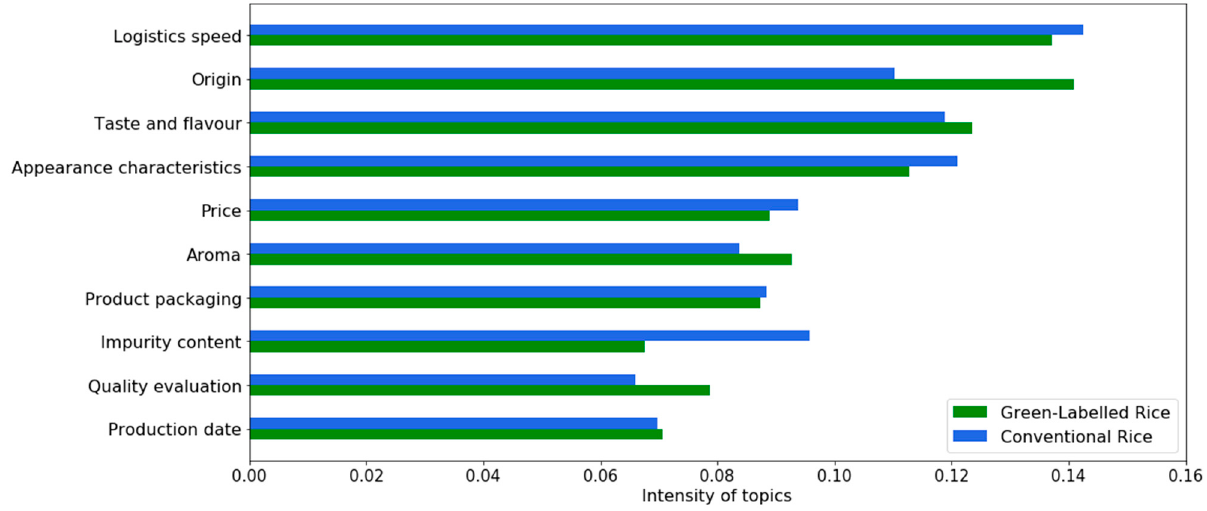
Figure 4. Comparison of topic weights for green-labelled rice and conventional rice Consumer attitudes towards the two types of rice differed under the same topic.